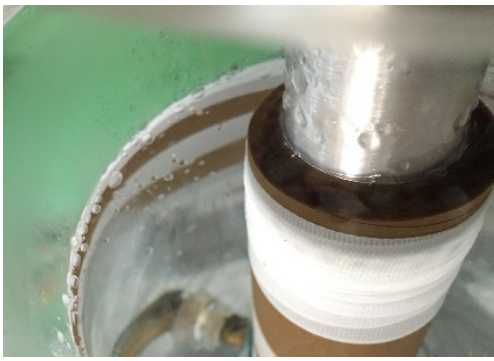
Figure 4. Phenomenon of MI into bushing